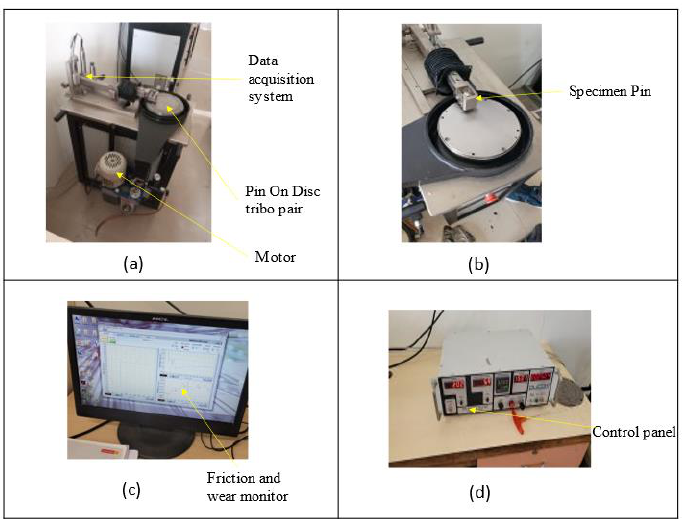
Figure 2. The pin on disc set up, ( a ) total set up, ( b ) specimen pin and disc, ( c ) the data acquisition and monitor, and ( d ) the control panel.